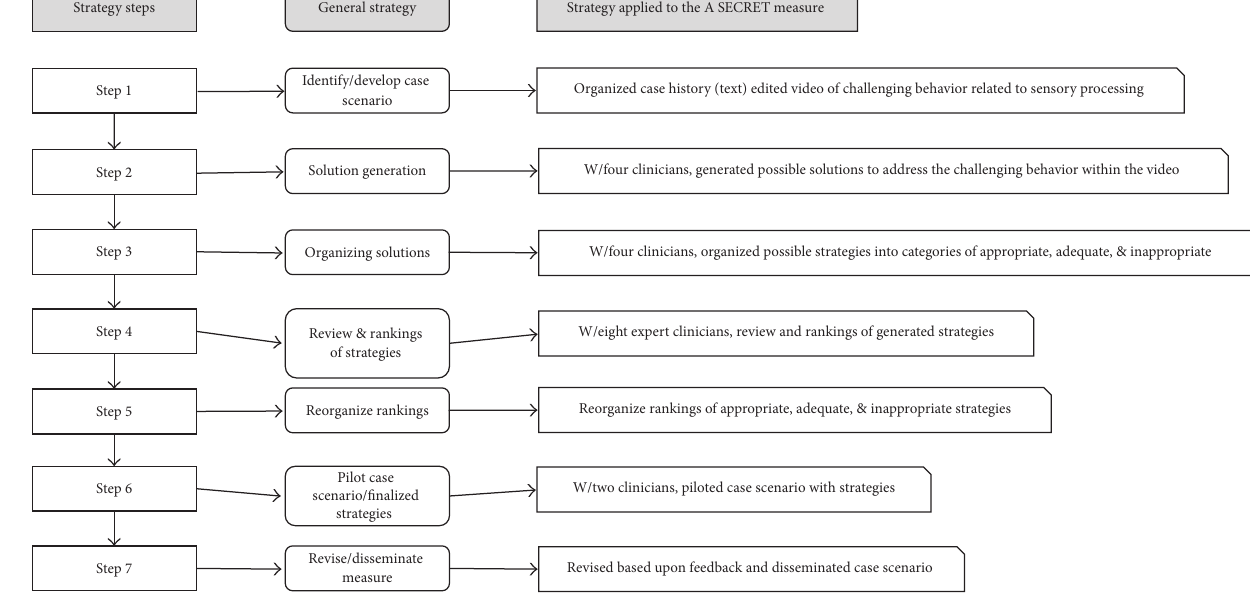
Figure 1: Case scenario development process.